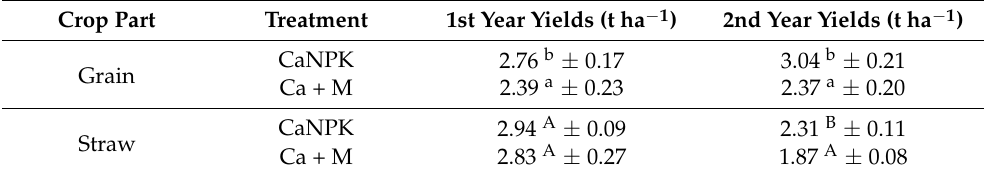
Table 5. Rye grain and straw